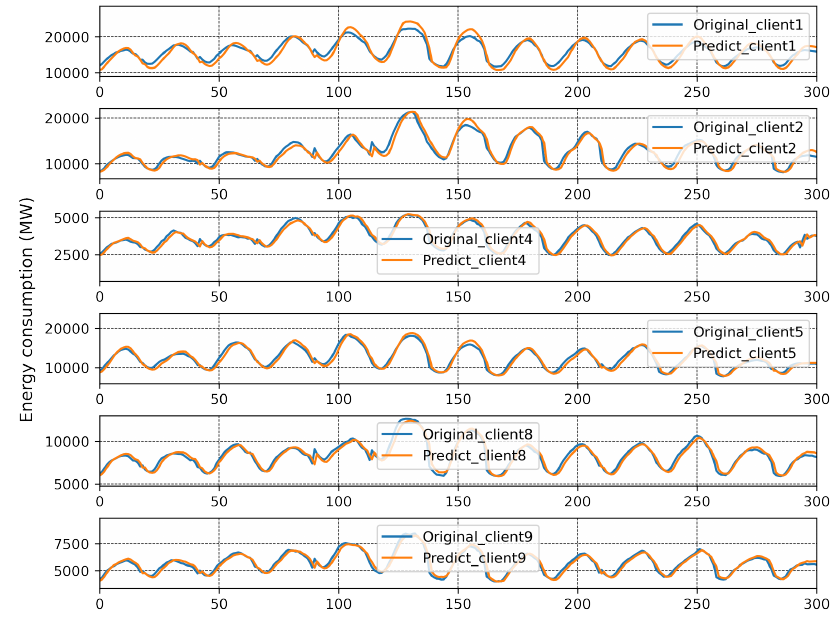
Figure 13. Prediction result of Branch